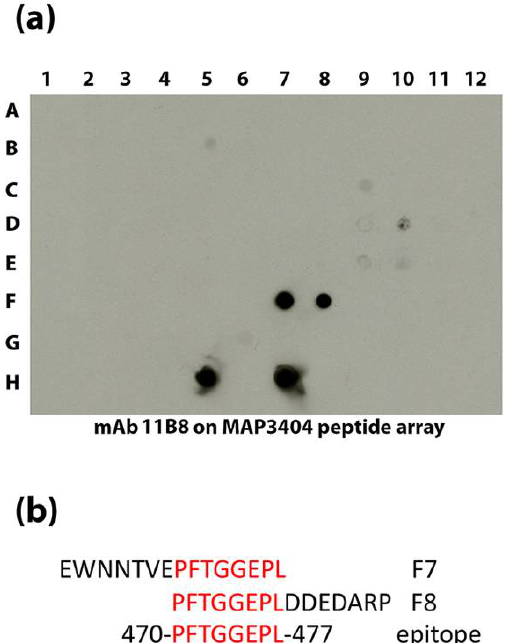
Figure 5. The epitope for 11B8 is defined to eight amino acids. An overlapping peptide library was spotted onto nitrocellulose and exposed to 11B8 ( a ). In addition to the native protein spotted in H5 and H7, the antibody reacts to overlapping peptides spotted in F7 and F8. The 15-amino acid peptides in F7 and F8 are shown ( b ) along with the overlapping amino acids highlighted in red. The consensus epitope is shown at the bottom and occurs at 470 to 477 in MAP_3404.